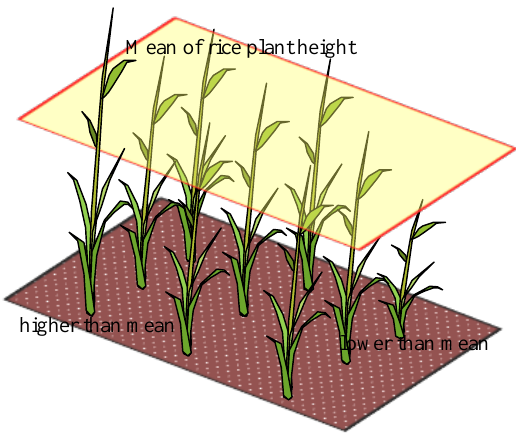
Fig.8 Image of rice growth unevenness in a rice field